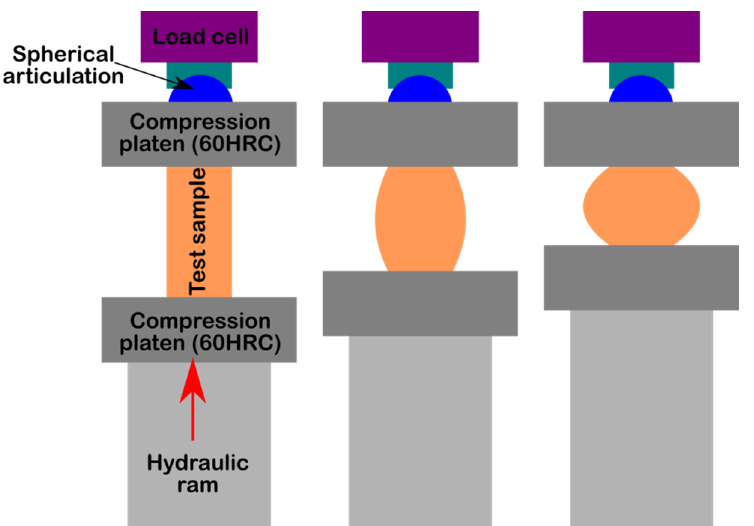
Figure 5. Schematic depicting the experimental set-up used for compression testing and sample behavior during the test (image not to scale).